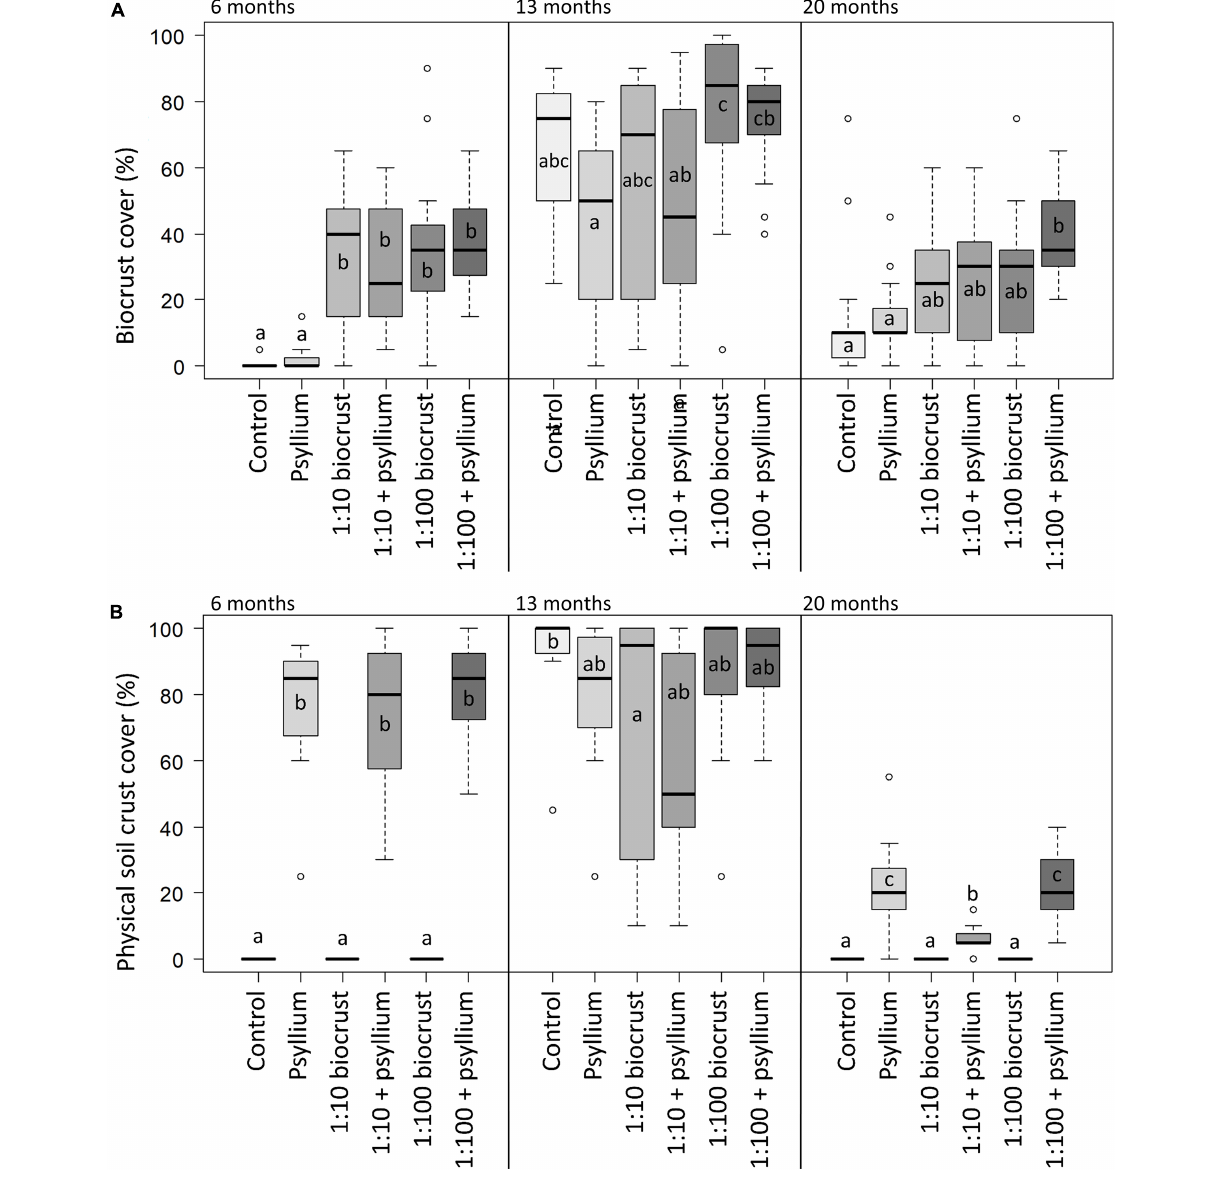
FIGURE 3 | (A) Biocrust cover and (B) physical soil crust cover. Box and whisker plots representing the range of values for biocrust cover observed in each treatment, in each season. Boxes show the median (horizontal line) and interquartile range (top and bottom of the box). Whiskers show the furthest point that is within 1.5 times the interquartile range. Outliers are represented by hollow circles. Pair-wise comparisons of means were tested using Kruskal-Wallis and Dunn’s tests. Letters compare means among treatments within each monitoring season; treatments that do not share a common letter differ significantly ( P <